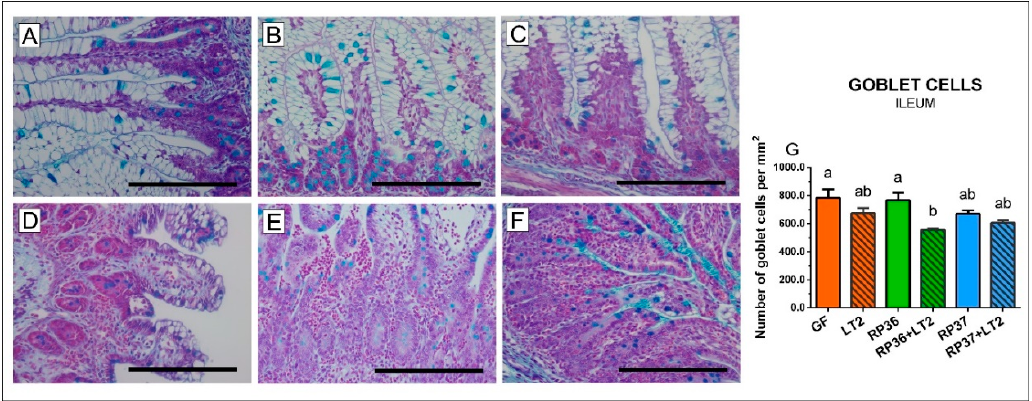
Figure 4. Goblet cells density in the ileum of gnotobiotic piglets: Germ-free (GF; ( A )), colonized with B. boum RP36 (RP36; ( B )), colonized with B. boum RP37 (RP37; ( C )), infected with S . Typhimurium LT2